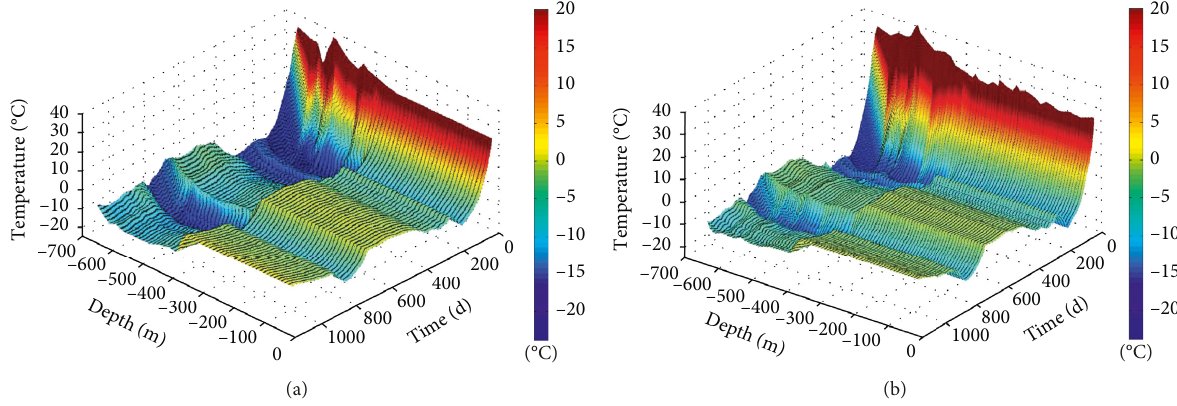
Figure 14: Development law of the temperature field between the inner ring freezing hole and the well wall. (a) Temperature change law of the temperature-measuring hole C4 ( ° C). (b) Temperature change law of the temperature-measuring hole C5 ( °